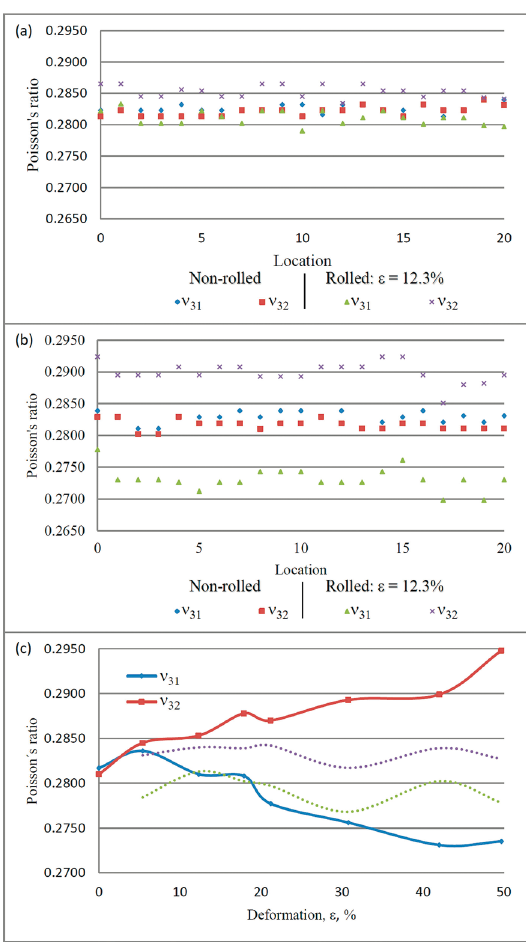
Figure 2. Poisson’s ratios measured at 21 locations on samples; (a) non-cold rolled and rolled to ε=12.3%; (b) non-cold rolled and and ν versus rolled to ε=42%. (c) Average of Poisson’s ratios ν 31 32 cold deformation (dotted lines indicate the range of fluctuation of and ν before rolling). values of ν 31 32 on the average values of ν and ν is shown in Figure 2c. 31 32 For comparison, the dotted lines also shown indicate the range of fluctuation of the individual values of ν and ν 31 32 along the 21 points measured on each of the seven samples before rolling. Figure 3 summarizes the effect of cold rolling on the difference between average values of Poisson’s ratios (that is, the difference between the curves of Figure 2c), and on birefringence. It is seen that ∆ ν = ( ν ̅ – ν ̅ ) increases linearly 31 32 with deformation from -0.0007 to 0.0213. Likewise, the average birefringence B, which is barely -0.0011 in the hot rolled condition, reflecting its nearly isotropic behavior, increases linearly with cold deformation to 0.0346. Equations (8) and (9) give the respective relations: